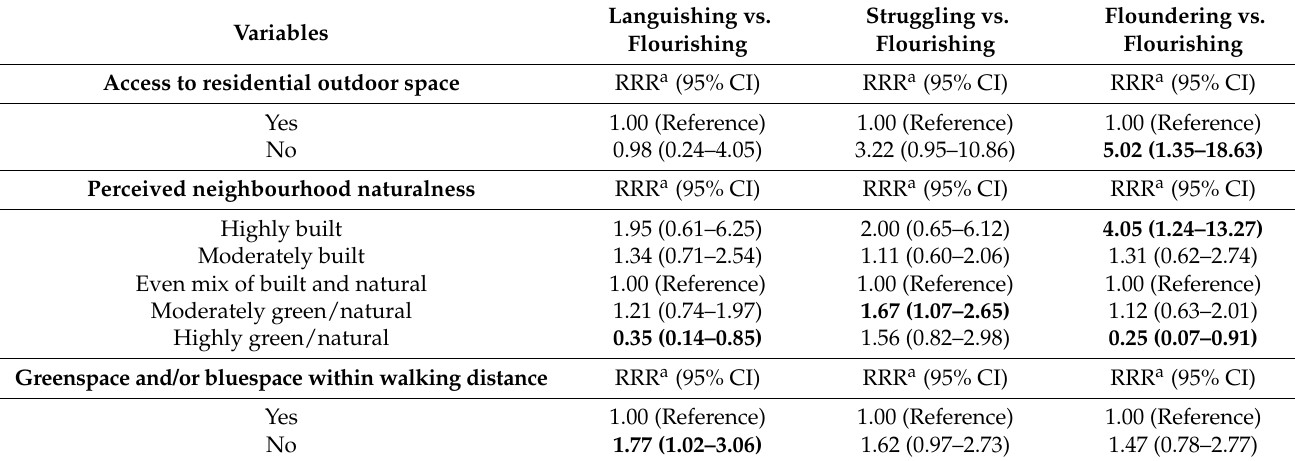
Table 5. Associations between access to nature, incidental contact with nature, and mental health state during the COVID-19 pandemic. Variables